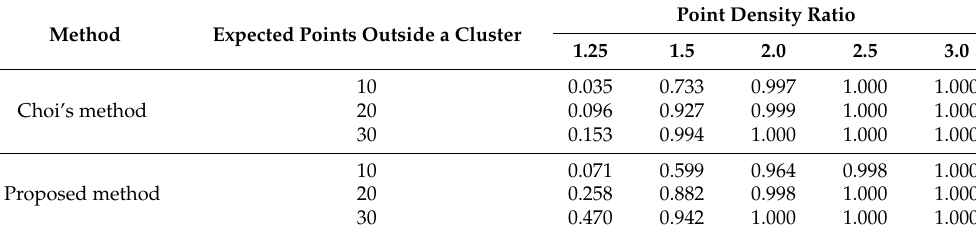
Table 3. Evaluation results for the power.